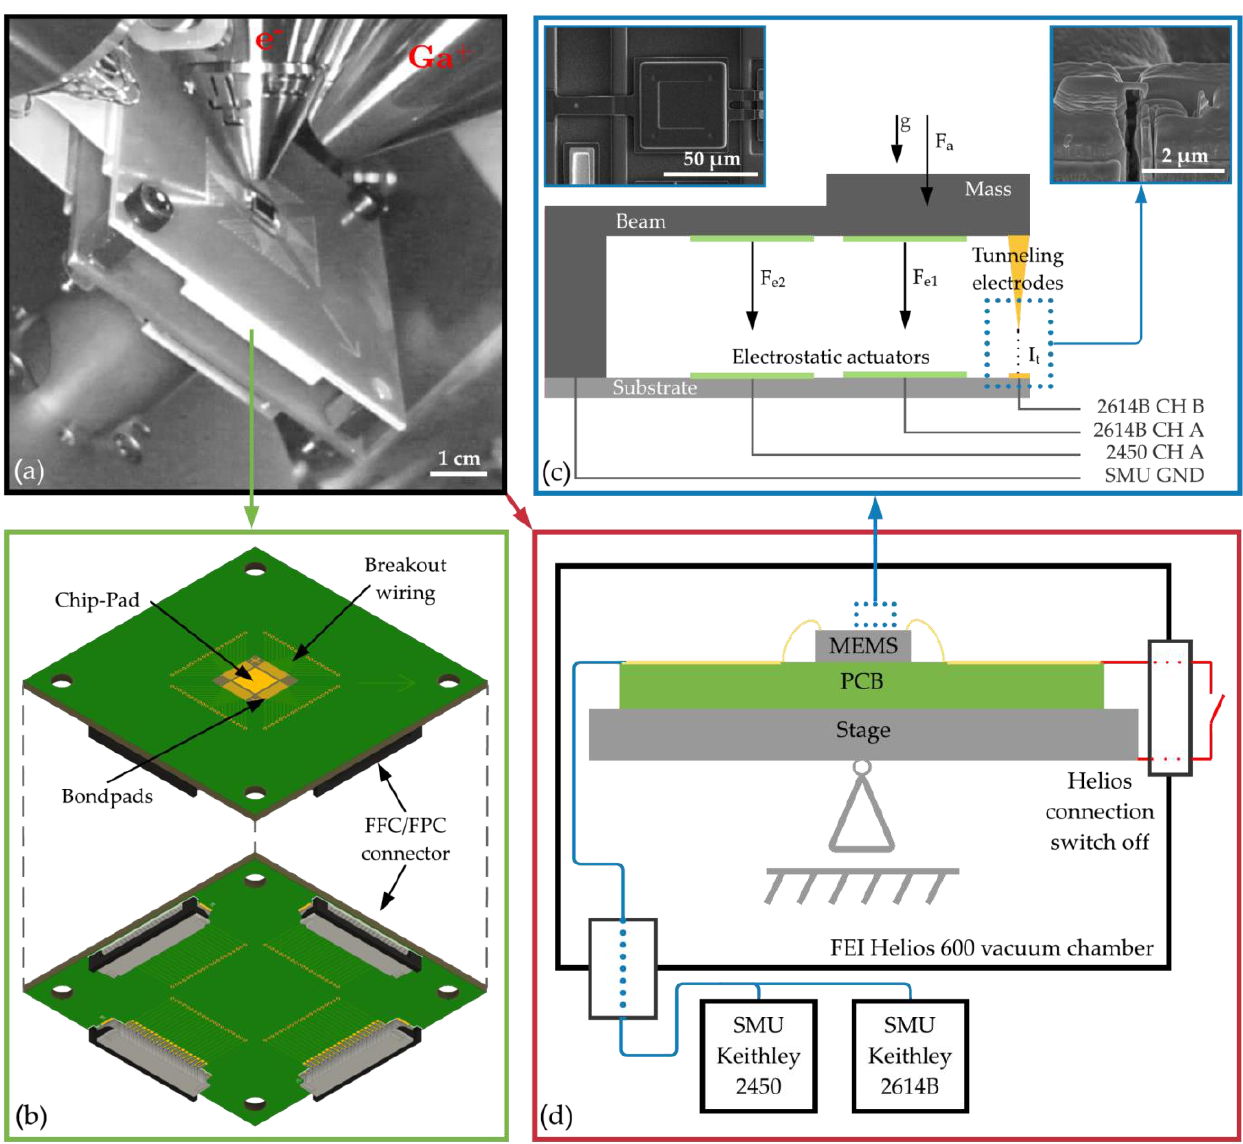
Figure 9. Test setup in the Helios vacuum chamber ( a ) and in detail the circuit board ( b ), the wiring of the sensor structure, and the FIB tunneling tips ( c ), and the schematic of the test setup ( d ).